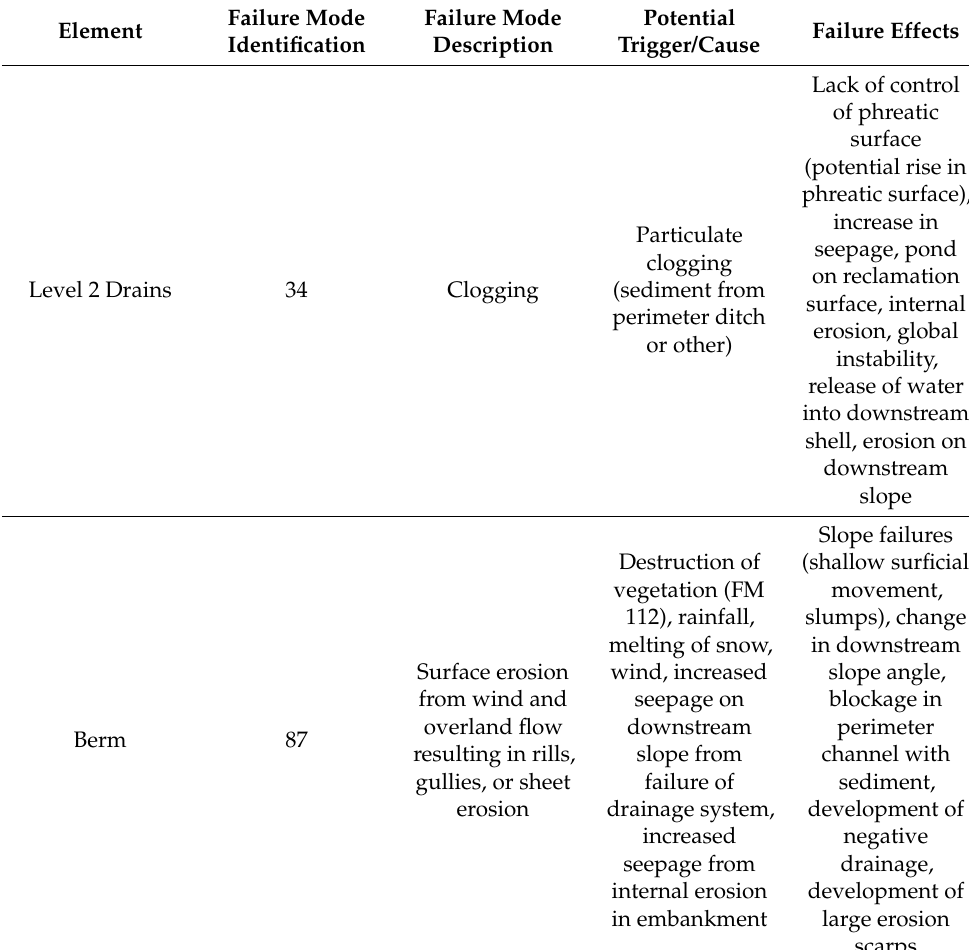
Table 5. Demonstration failure